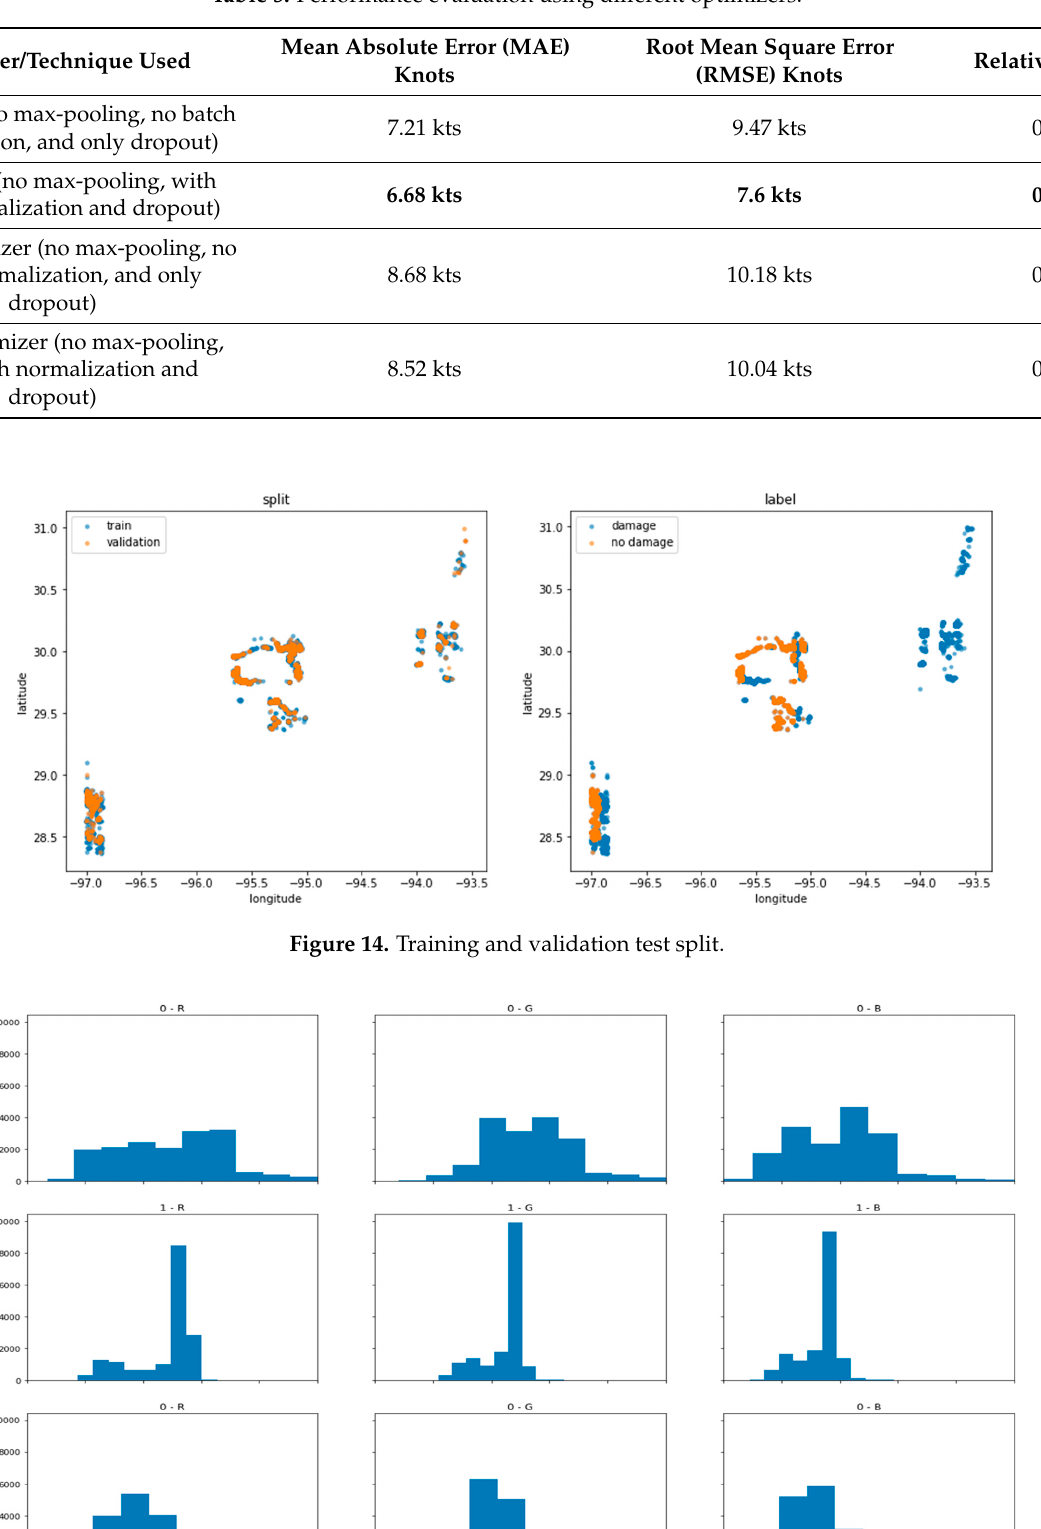
Table 5. Performance evaluation using different optimizers.